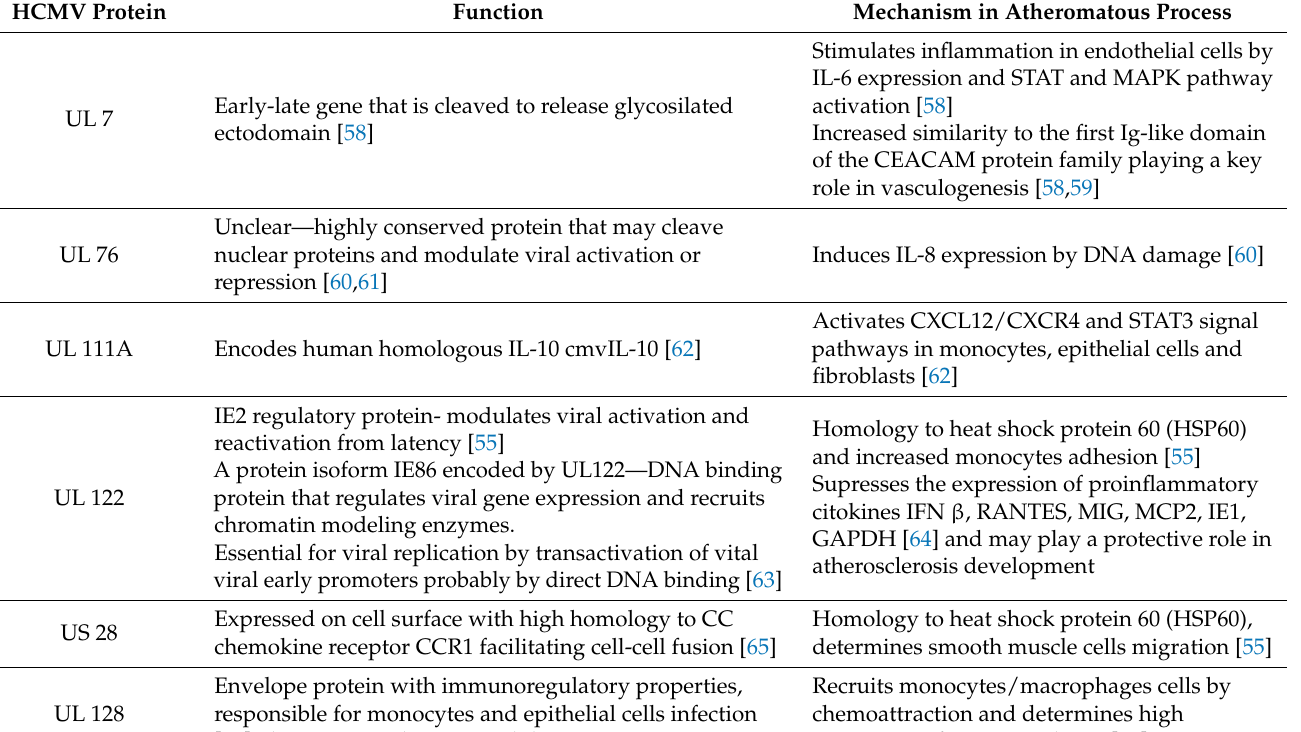
Table 2. CMV encoded proteins and the expression of humoral factors involved in